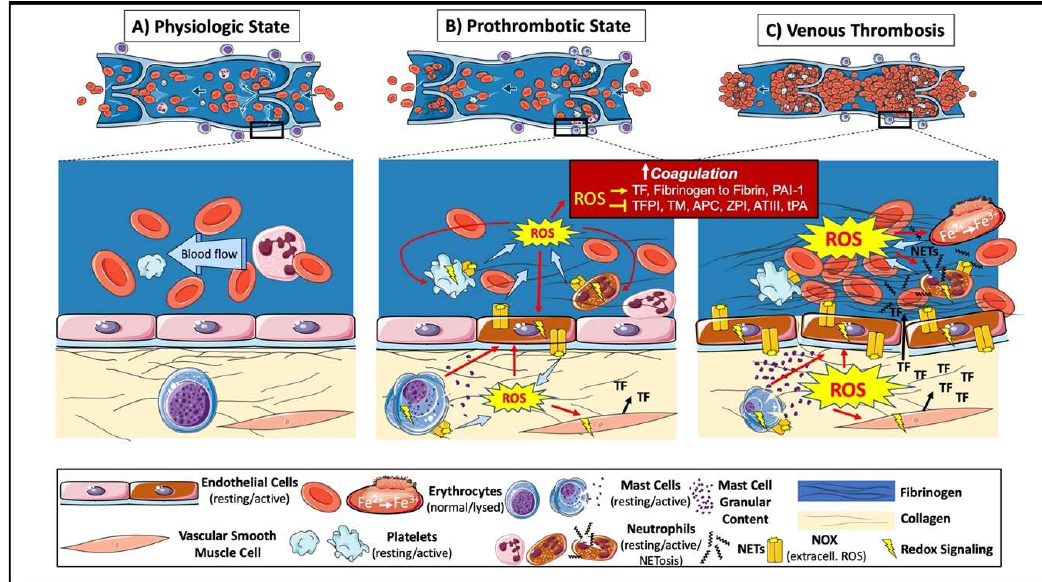
Figure 2. ROS in the formation of a venous thrombus. A) Physiologic venous circulation. B) At